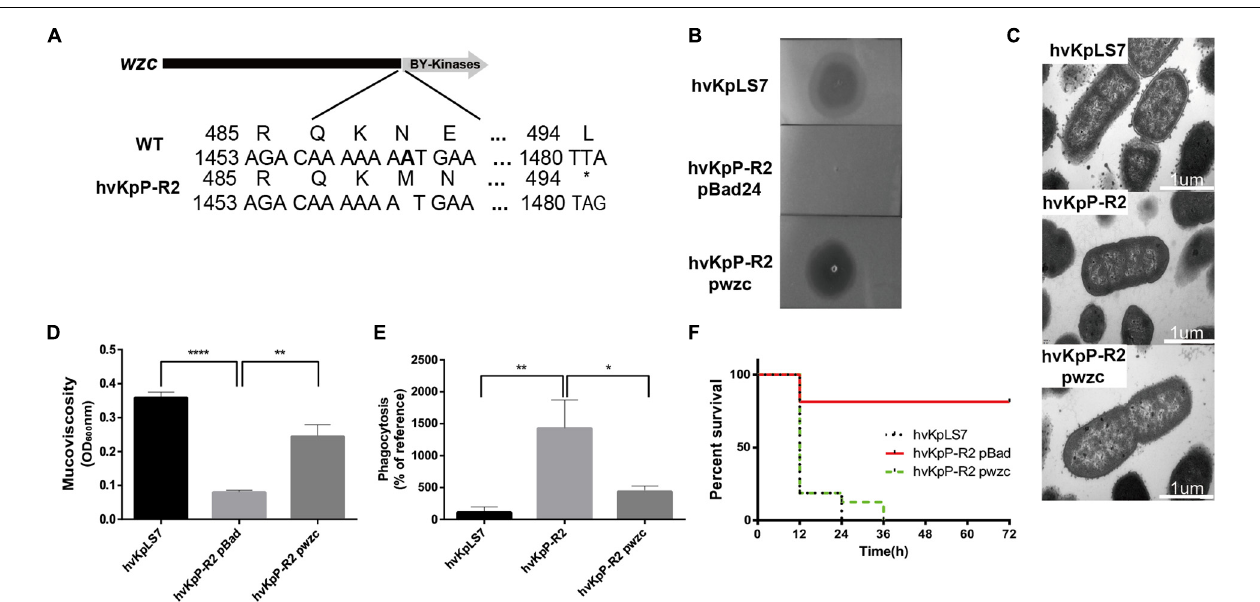
FIGURE 5 | Sensitivity and virulence of the wzc mutant restore phage by complementation. (A) Schematic representation of wzc in K. pneumoniae hvKpLS7 and hvKpP-R2. Genes are represented as arrows. (B) Spot test assay of phage on the parental K. pneumoniae strain hvKpLS7 and its derived mutants (hvKpP-R2 pBad and hvKpP-R2 pwzc). (C) The wzc gene affects capsule production. TEM of WT, phage-resistant, and complementation strain. For every isolate, one representative image from six images obtained from one section is shown. (D) Mucoviscosity is restored in hvKpP-R2 pwzc. (E) Phagocytosis by RAW264.7 macrophages of WT, phage-resistant, and wzc gene complementation strain. (F) Survival rates of G. mellonella with hvKpLS7, hvKpP-R2 pBad, and hvKpP-R2 pwzc. One-way ANOVA was performed to determine statistically significant differences. * p < 0.05, ** p < 0.01, **** p <